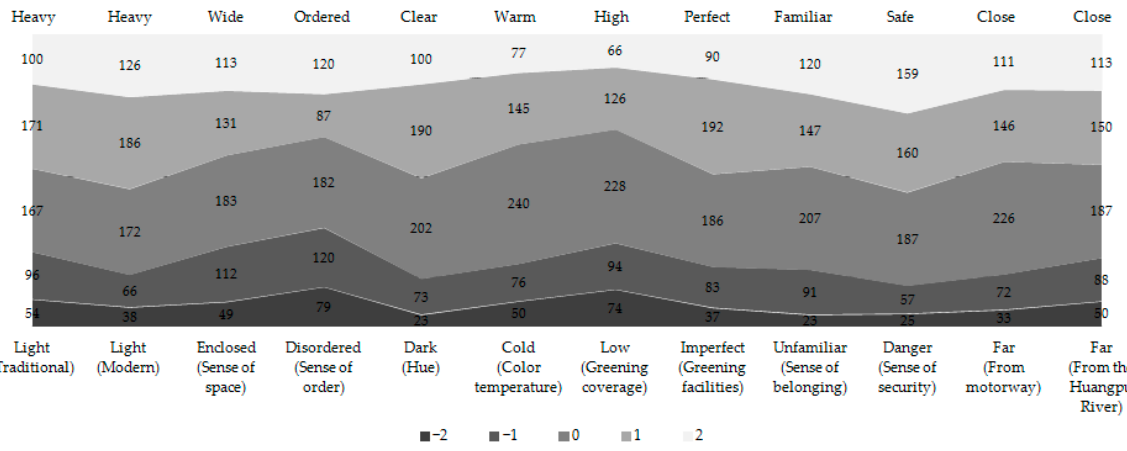
Figure 6. Frequency distribution of semantic differential evaluation elements of the Huangpu riverside greenways.